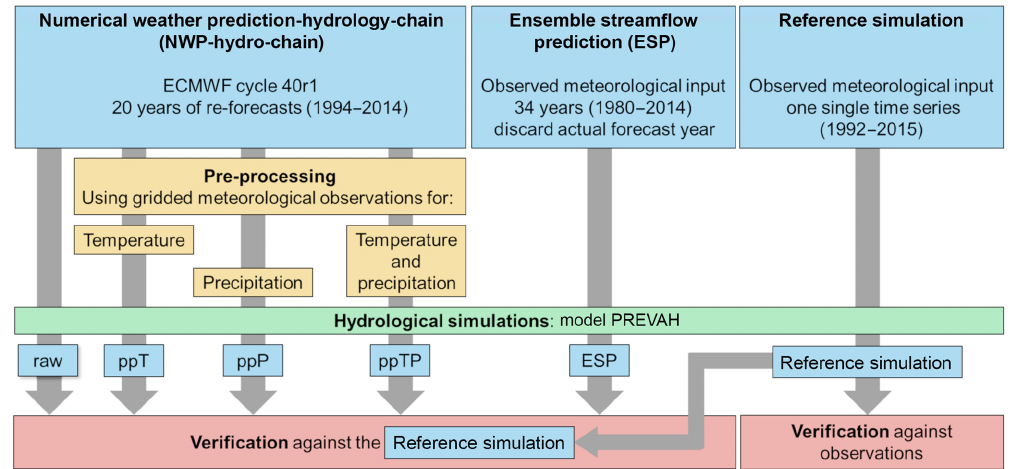
Figure 1. Conceptual design of the NWP-Hydro-chain with and without pre-processing (left) and the ESP chain